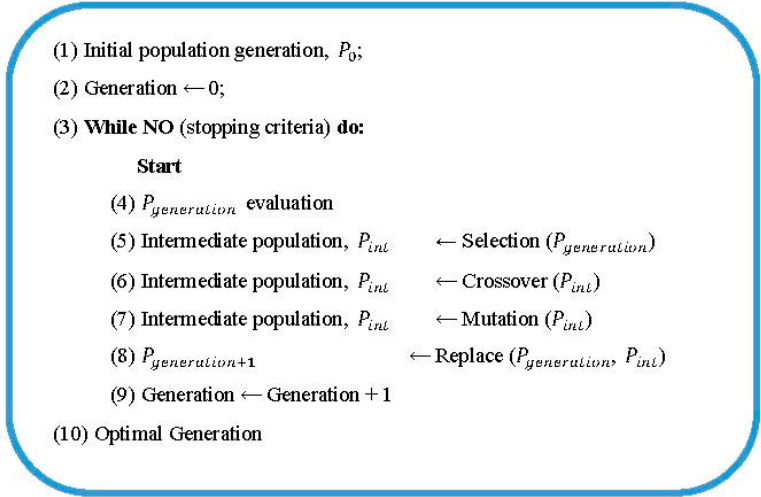
Figure 6. GA pseudocode.